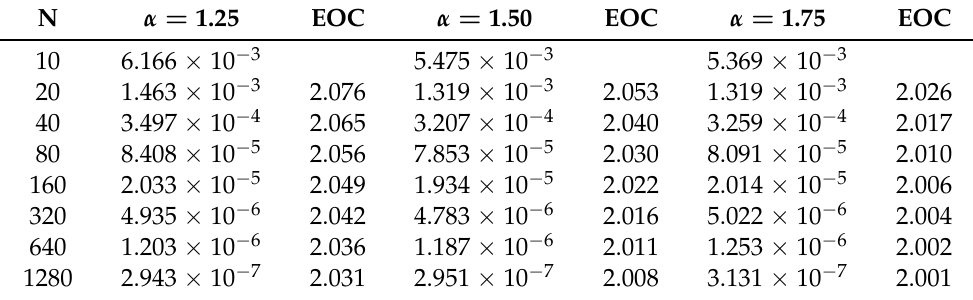
Table 2. Table showing the maximum absolute error and EOC for solving (47) using the predictor– corrector method for α >